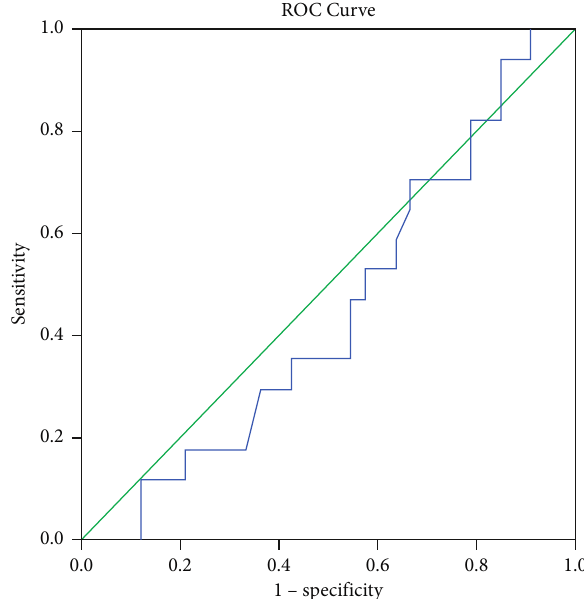
Figure 1: ROC curve showing the predictive validity of the